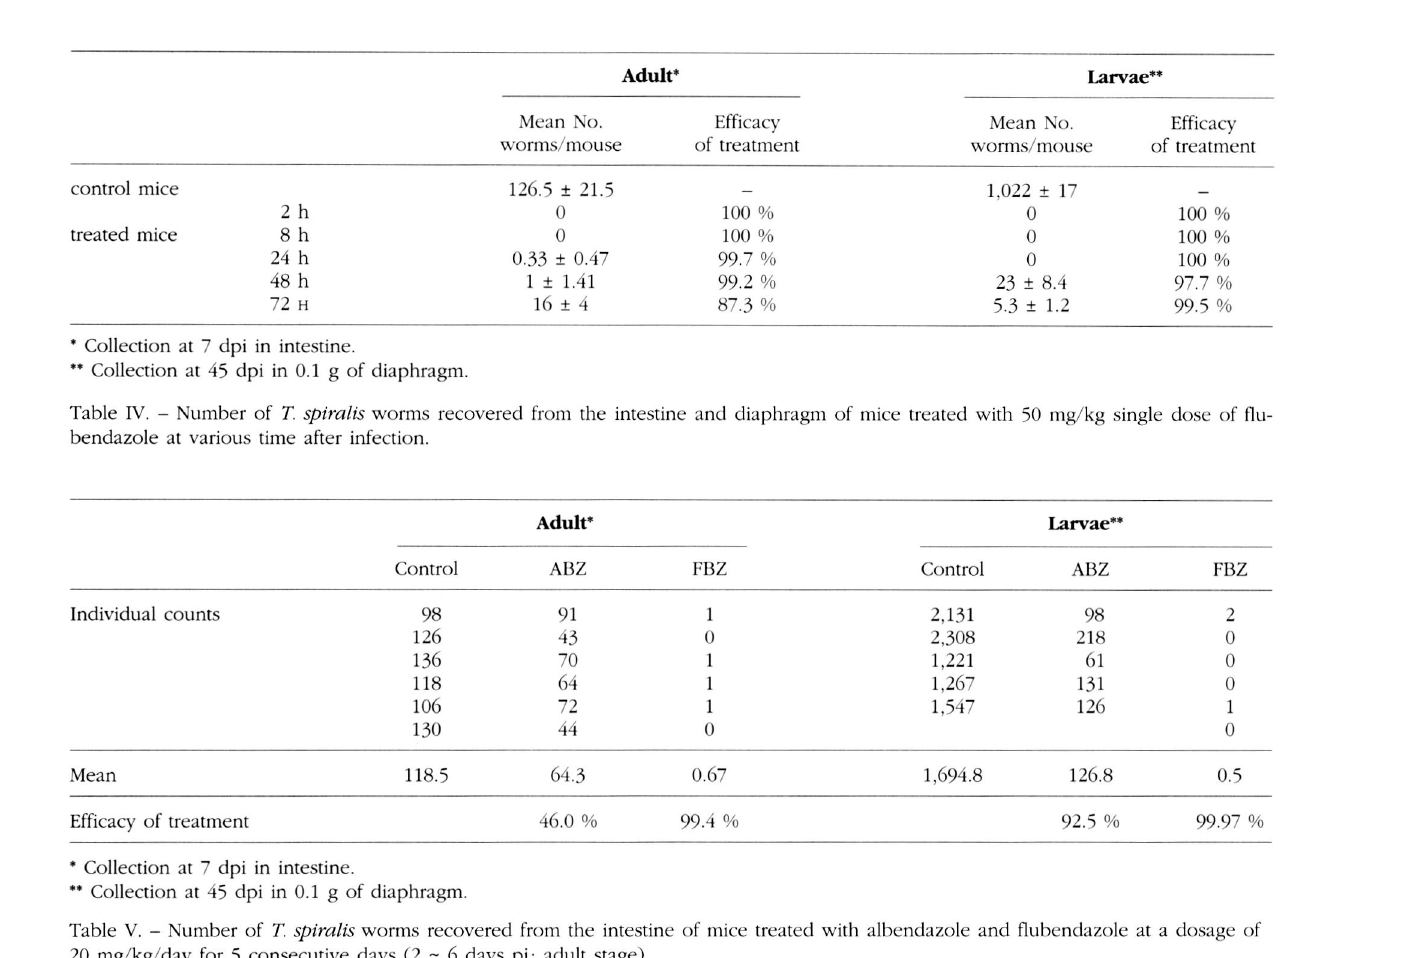
Table V. - Number of T. spiralis worms recovered from the intestine of mice treated with albendazole and flubendazole at a dosage of 20 mg/kg/day for 5 consecutive days ( 2 -6 days pi; adult stage).